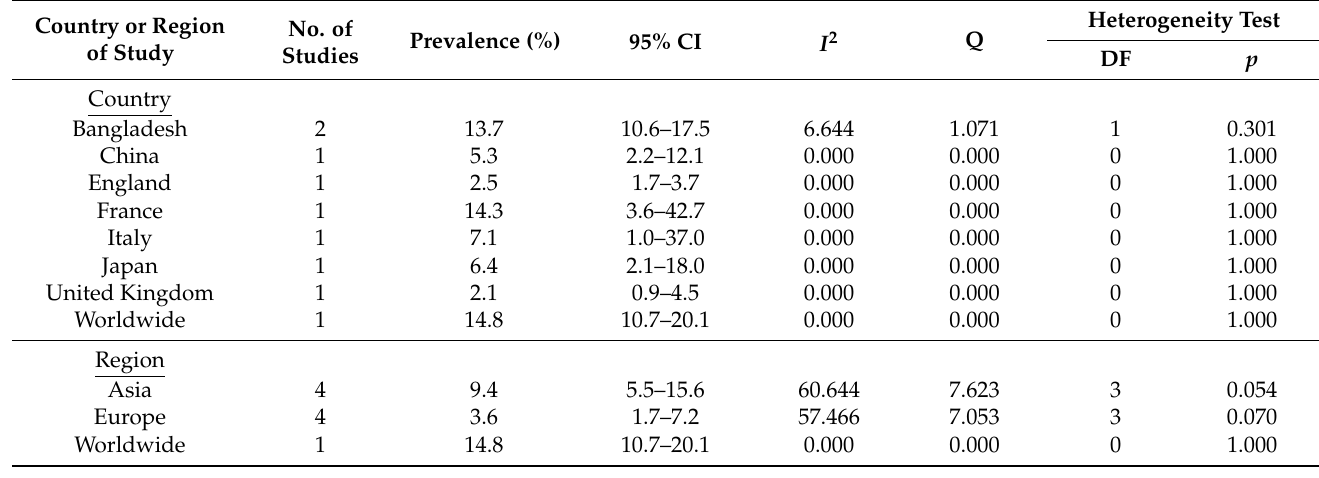
Table 6. Sub-group analysis of prevalence parE gene in S. Typhi according to regions.